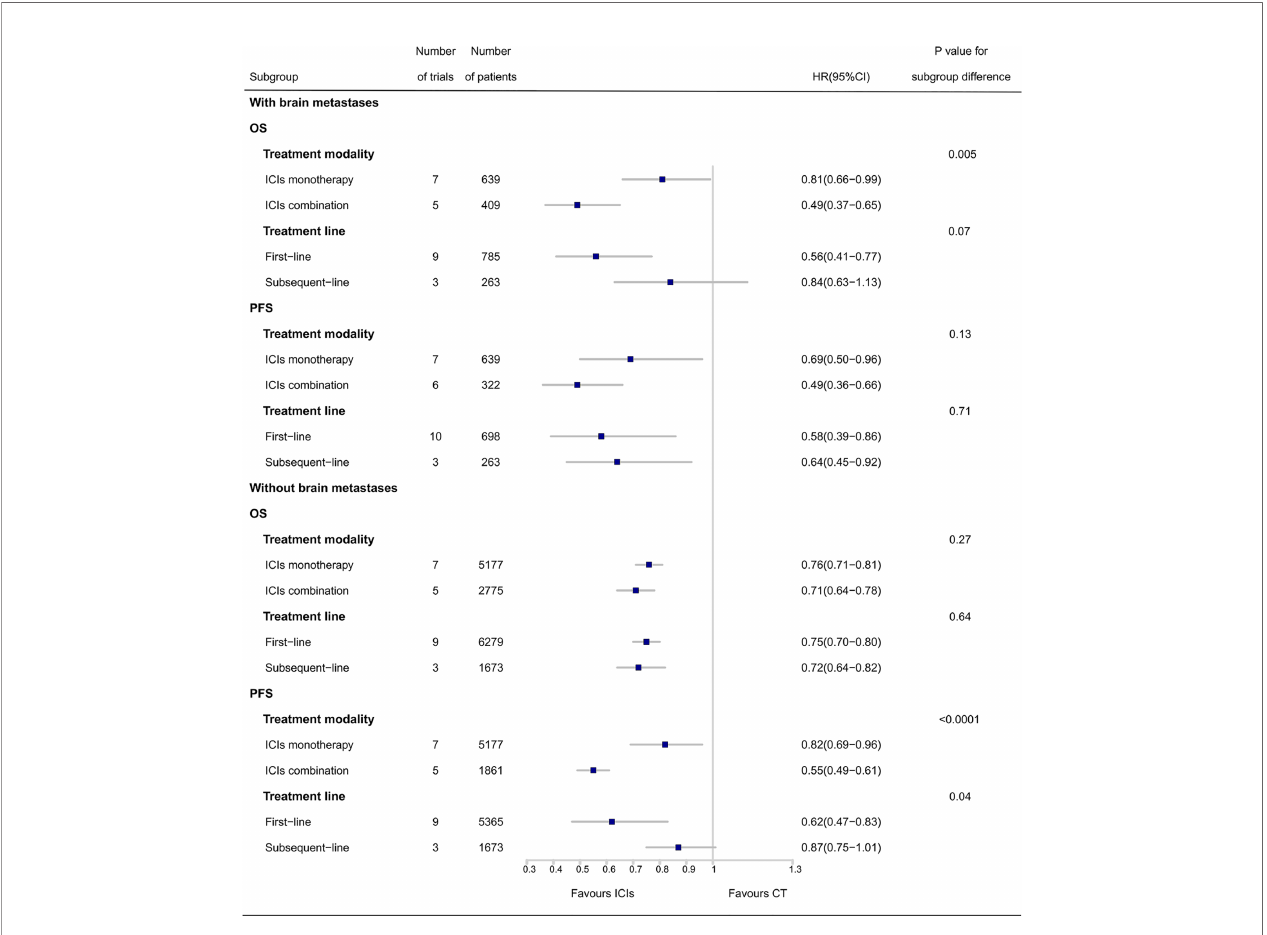
FIGURE 4 | Subgroup analyses of ICIs ef fi cacy in patients with and without brain metastases. OS, overall survival; PFS, progression-free survival; ICIs, immune checkpoint inhibitors; CT, chemotherapy; HR, hazard ratio; CI, con fi dence